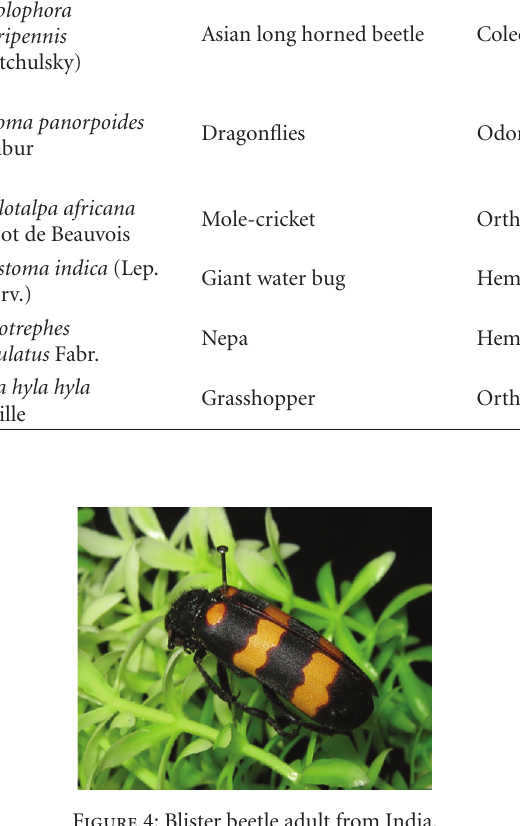
Figure 4: Blister beetle adult from